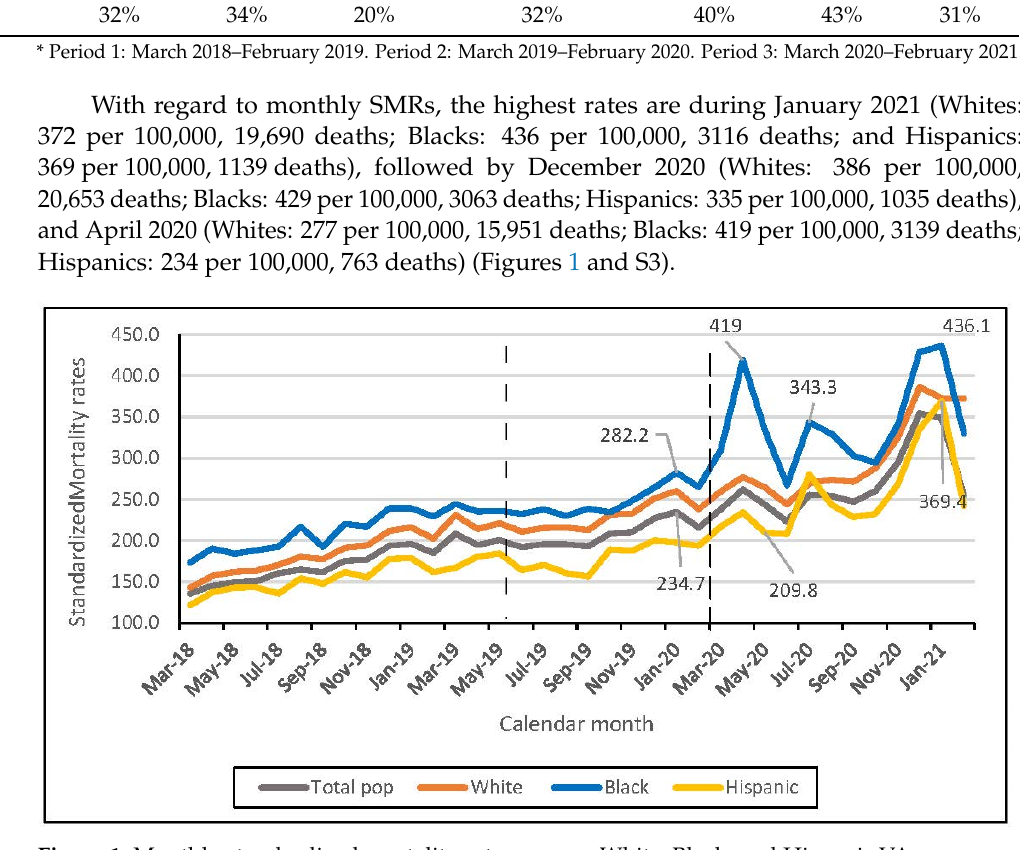
Figure 1. Monthly standardized mortality rates, among White, Black, and Hispanic VA users over